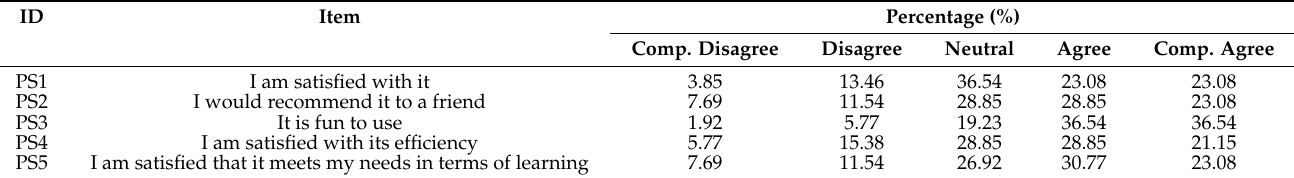
Figure 7. Survey results for ‘Perceived Satisfaction’. Table 4. Numerical results for ‘Perceived